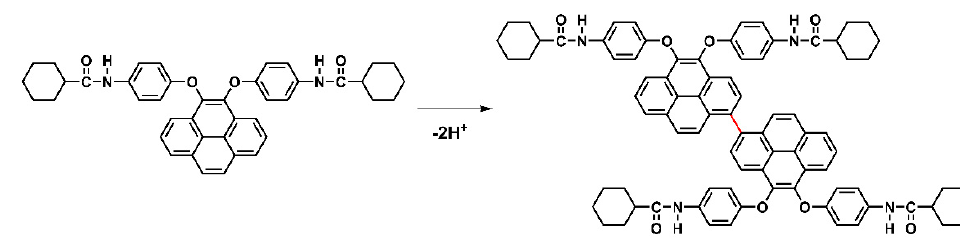
Scheme 5. Proposed structures of electro-generated dimers of model compound M2 .